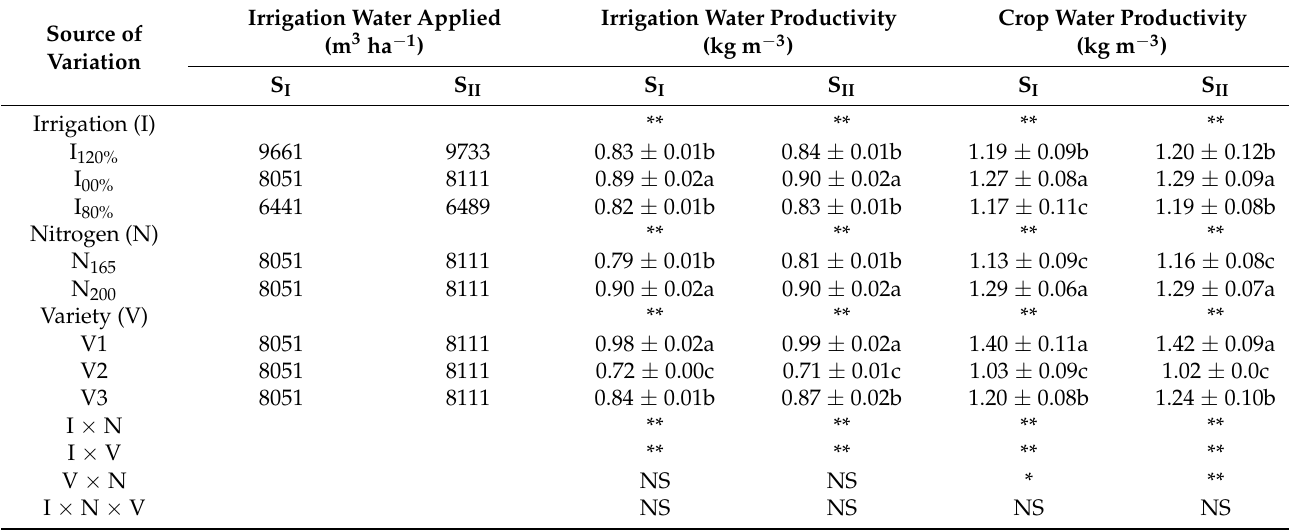
Table 7. Effect of deficit irrigation, nitrogen fertilizer varieties, and their interaction on grain yield, straw yield, biological yield, irrigation water productivity and crop water productivity of rice plants in 2017 (S I ) and 2018 (S II ) seasons.